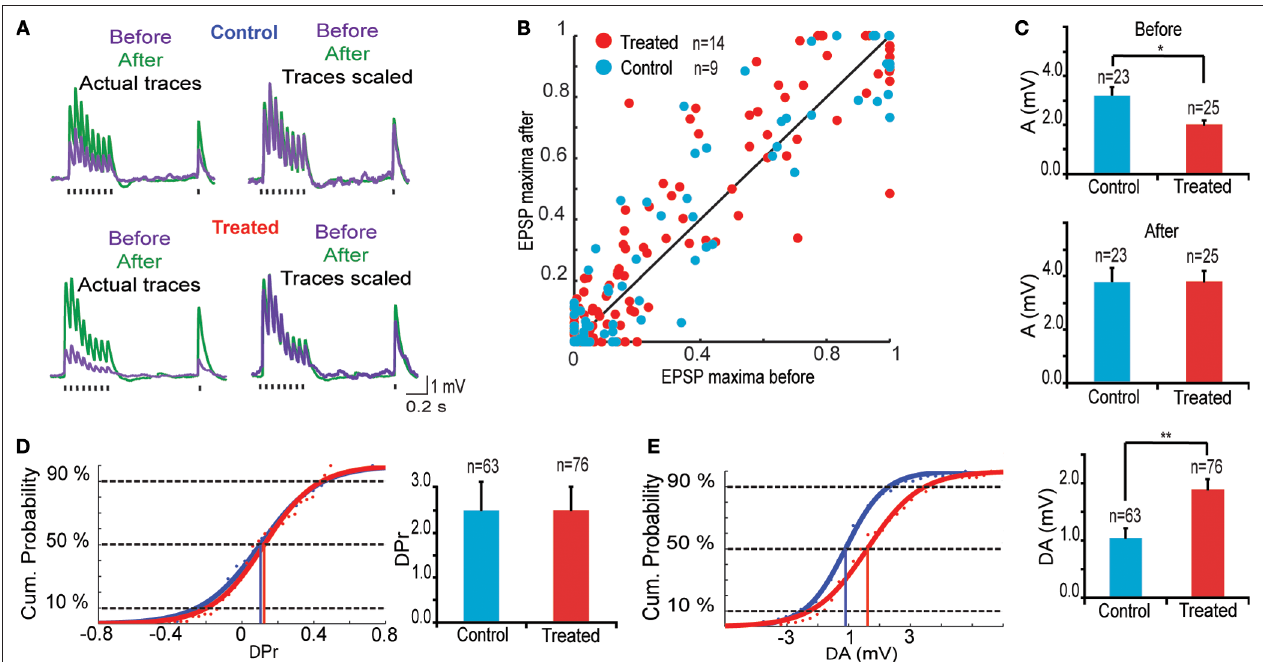
after network stimulation by sodium glutamate. (D) Cumulative probability − Pr histogram of Δ Pr = Pr . Highlighted points are those at 50% and after before correspond to the mean values for Δ Pr. No signifi cant difference in Pr between − A the two groups. (E) Cumulative probability histogram of Δ A = A . after before Highlighted points are those at 50% and correspond to the mean values for Δ A . Global increase in synaptic effi cacy signifi cantly higher for treated